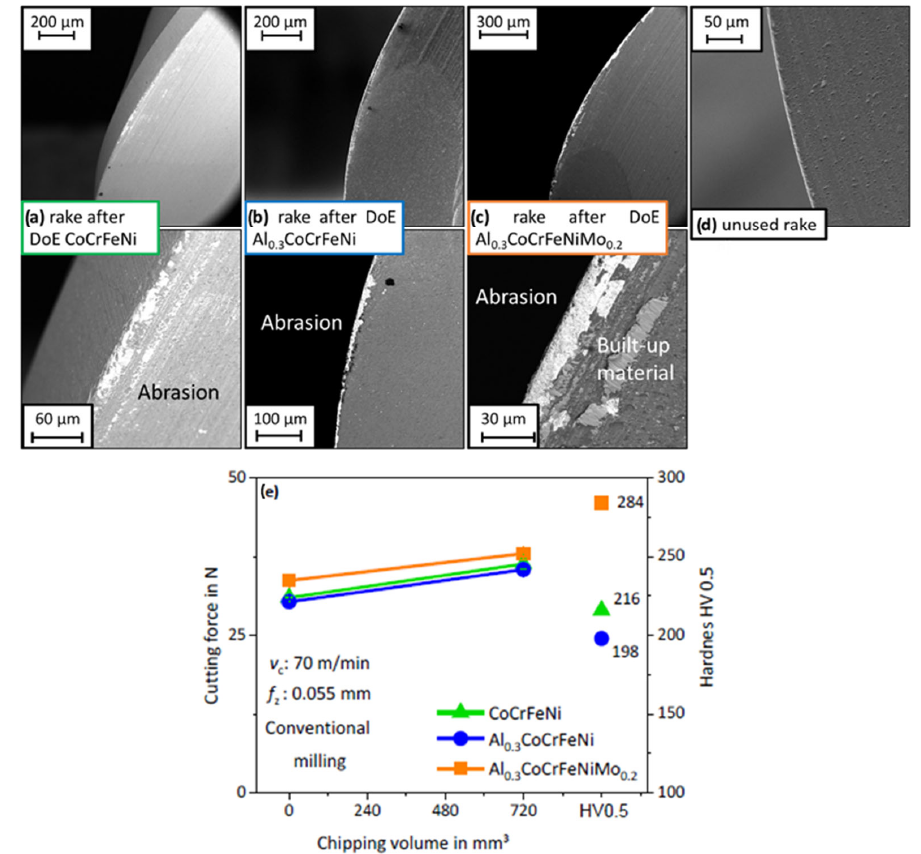
Figure 6. State of cutting tools after milling 700 mm 3 under varying conditions on the three alloys investigated ( a – c ), in comparison with unused tool ( d ) and influence of tool condition on cutting forces under the tool-manufacturer-recommended conditions ( e ).